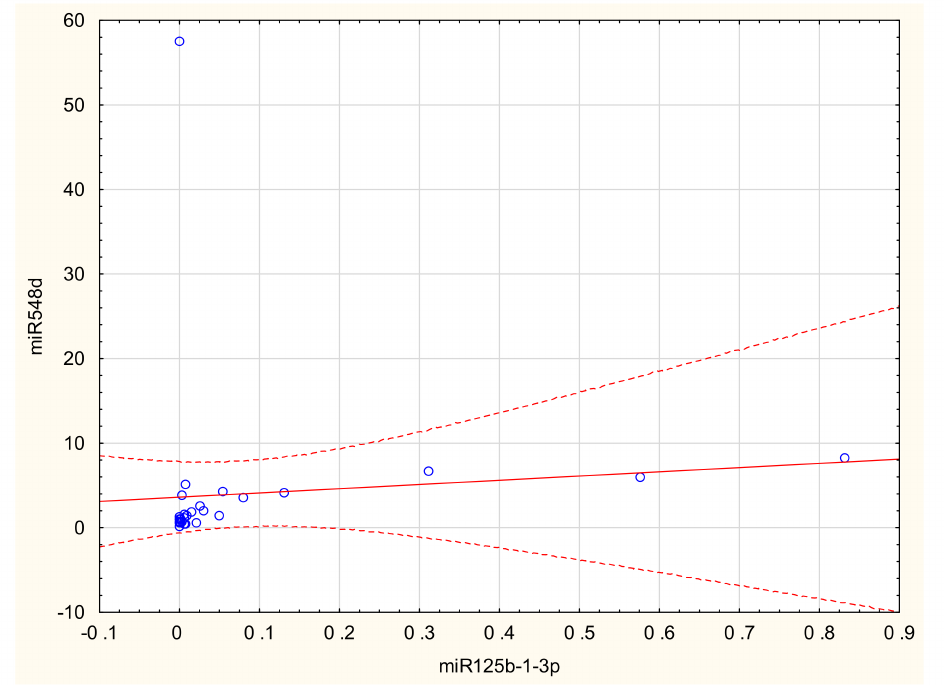
Figure 2. Correlation between miR125b-1-3p vs miR548d in scar endometriosis (R = 0.484; p = 0.02) (see also Supplementary File